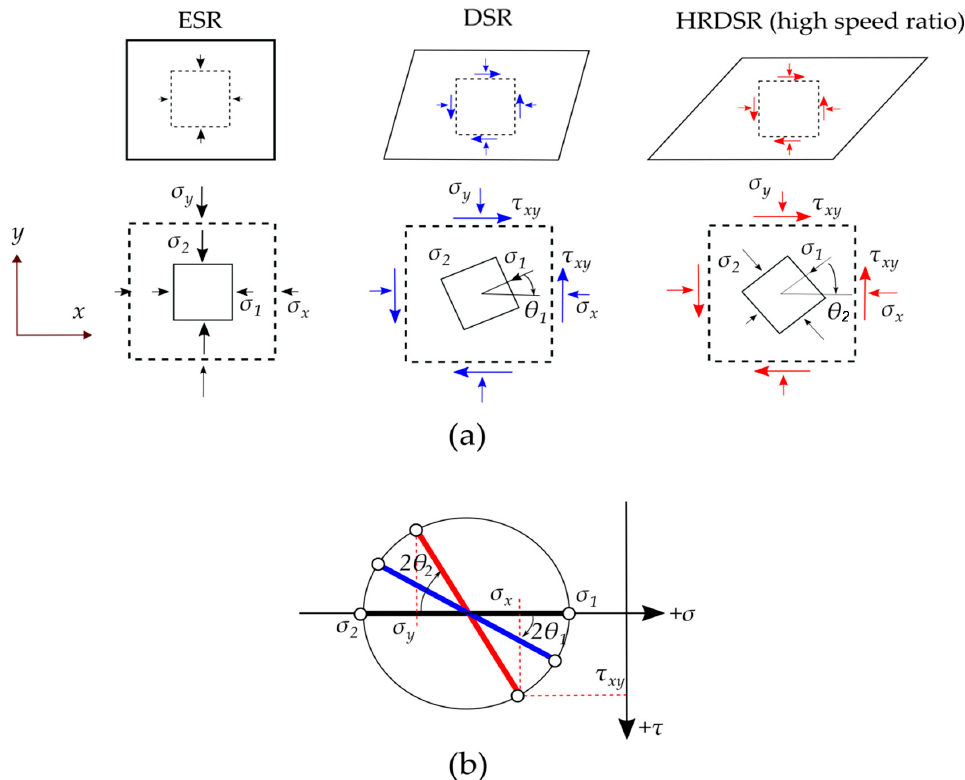
Figure 11. ( a ) Deformation of a square element after ESR, differential speed rolling (DSR), and HRDSR processes. ( b ) Mohr’s circle of stress representing the stress states corresponding to ESR, DSR, and HRDSR [49]. Reproduced with permission from Jeong et al., Mater. Sci. Eng. A ; published